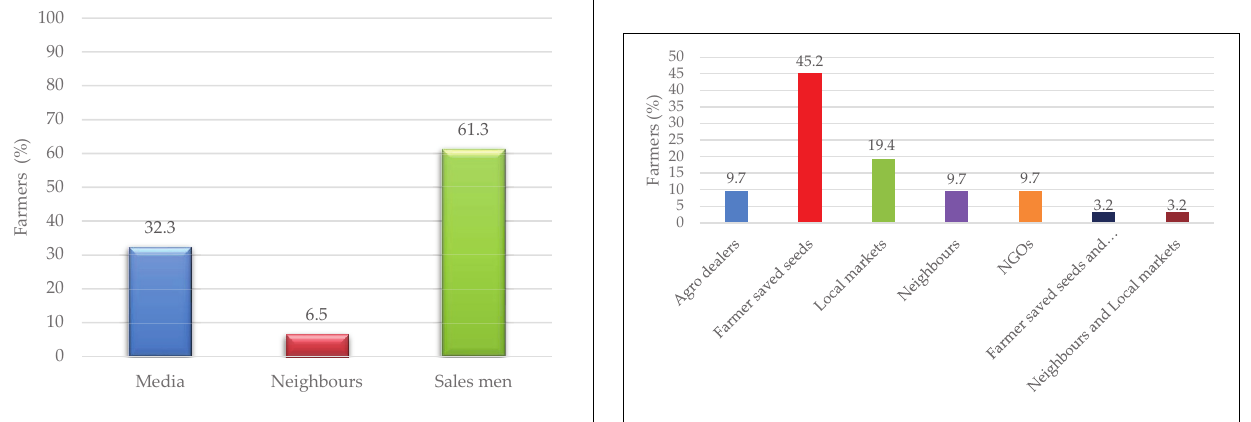
FIGURE 4 | Source of market information. FIGURE 5 | Sources of lablab